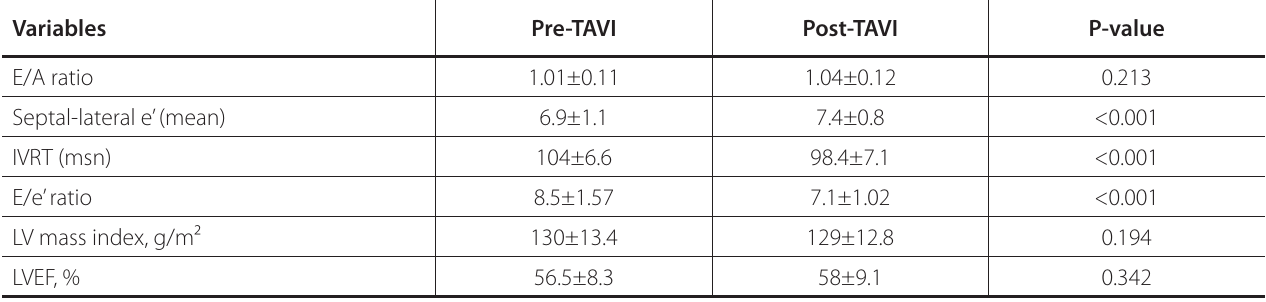
IVRT=isovolumetric relaxation time; LV=left ventricular; LVEF=left ventricular ejection fraction; TAVI=transcatheter aortic